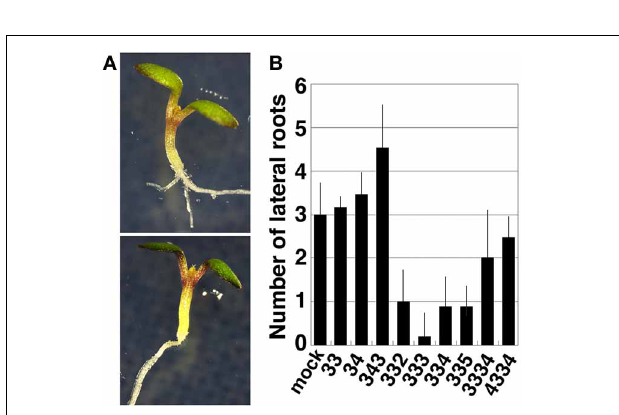
FIGURE 7 | Effect of polyamines on lateral root formation. (A) A wild-type seedling grown for 5 days in MS solutions (upper panel) and that supplemented with 100 µ M thermospermine (lower panel). (B) Number of lateral roots in wild-type seedlings grown for 5 days in MS solutions supplemented with 100 µ M each polyamine. Numbers correspond to those of the carbon shown in Table 1 . Error bars represent the SE ( n = 10).